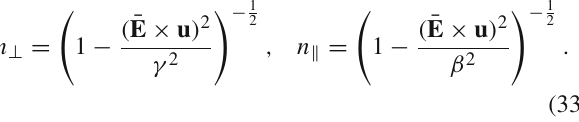
derived from Snell’s law